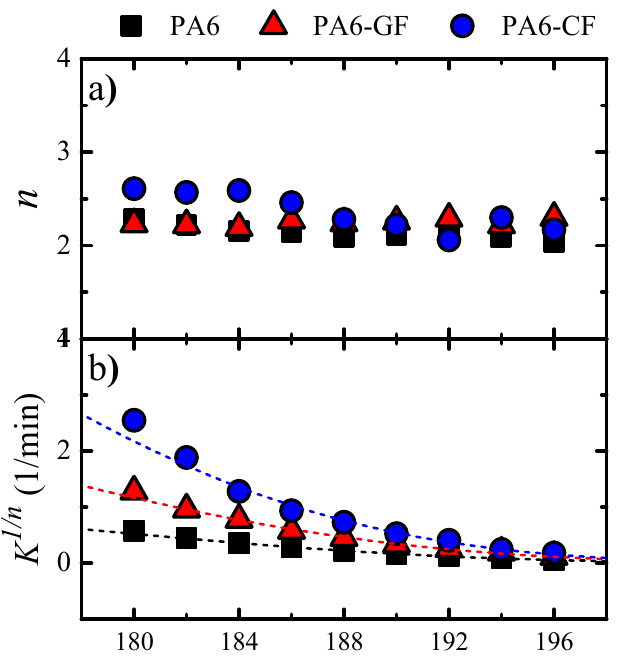
Figure 10. ( a ) Avrami index for the indicated samples as a function of T c . ( b ) Normalized crystallization constant of the Avrami model as a function of T c . Solid lines in ( b ) correspond to fittings to the Lauritzen–Ho ff man